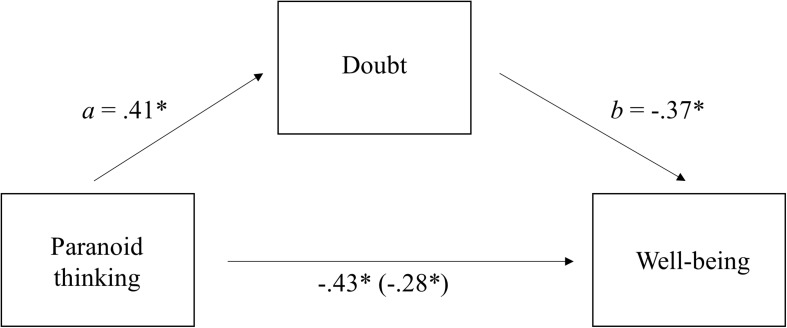
Doubt in one’s thoughts as a mediator between Paranoid Thinking and Well-being. Figure in the parenthesis (i.e., –0.28) is the direct effect of Paranoid Thinking on Well-being while accounting for the effect through the indirect path (∗p < 0.05).